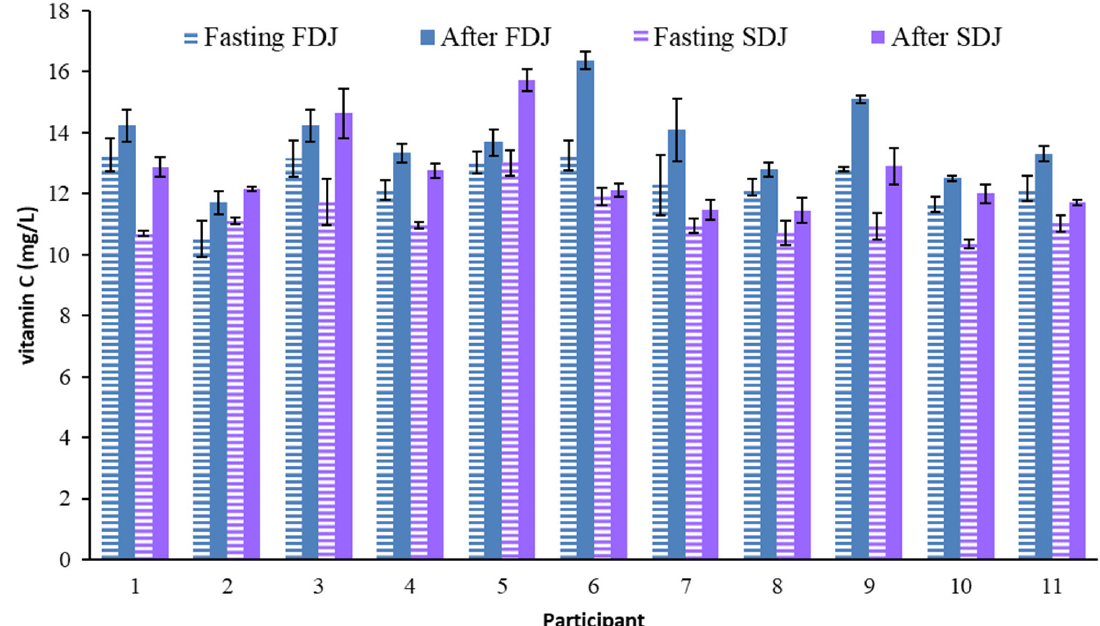
Figure 1. Mean value and standard deviation of serum blood VC concentration analyzed in the par- ticipants on the days of consuming reconstituted freeze-dried (FDJ) and spray-dried (SDJ) juices, both fasting and 4 h after the intake of each juice.